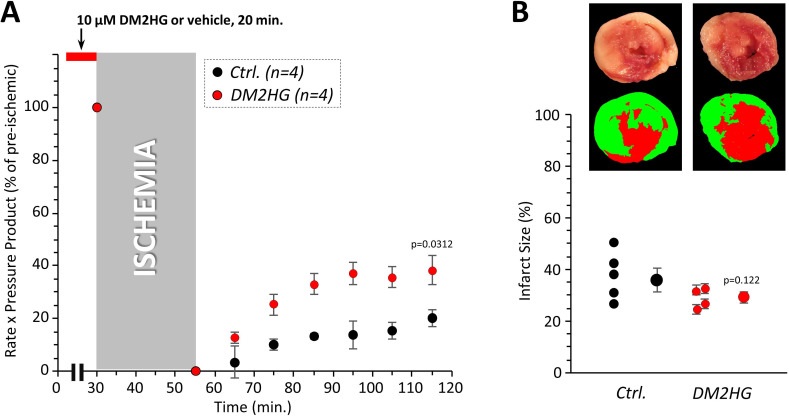
Cardioprotection against IR injury by dimethyl-L-2-hydroxyglutarate.Hearts from WT mice were Langendorff perfused and subjected to 25 min. ischemia plus 60 min reperfusion, with optional administration of 10 µM dimethyl-L-2-hydroxyglutarate (DM2HG) for 20 min prior to the onset of ischemia. (A) Cardiac function assessed by left ventricular balloon pressure transducer. Graph shows the product of heart rate multiplied by left ventricular developed pressure, as a percentage of the initial (pre-ischemic) value. (B) Post IR staining with TTC for quantitation of myocardial infarct size. Representative TTC-stained heart slices are shown, with pseudo-colored mask images used for quantitation by planimetry (red = live tissue, green = infarct). Data are quantified below, with individual data points to shown N, and means ± SEM. p-values (paired t-test) are shown above error bars. N for each experiment shown in parentheses.